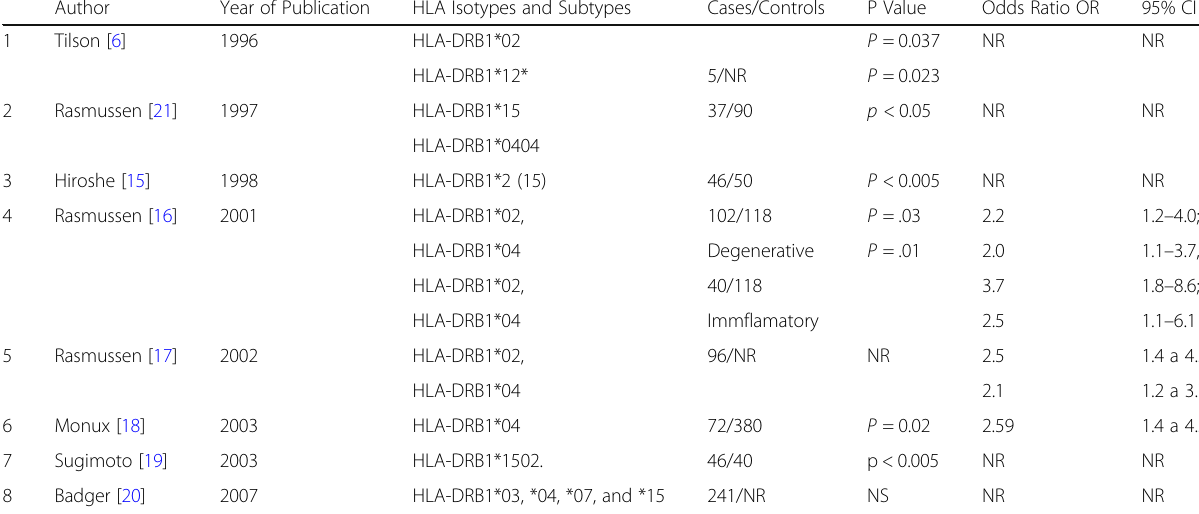
Table 3 Summary of case control studies of the association of HLA-DRB1 and Abdominal Aortic